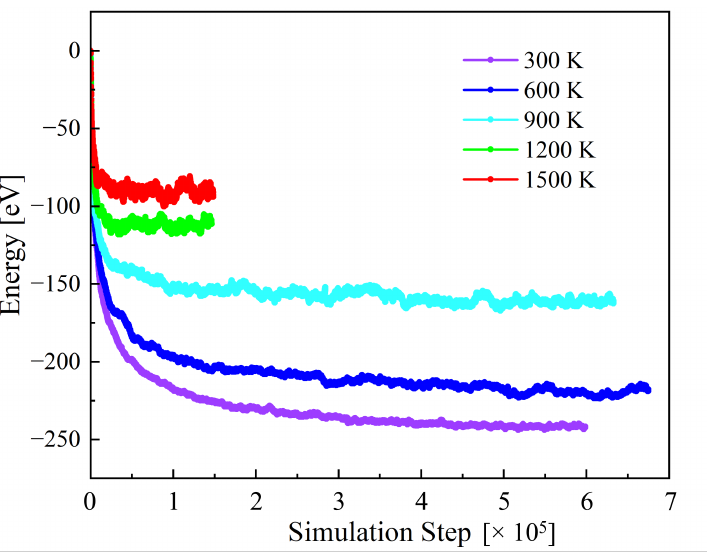
Figure 2. Energy evolution of the random Nb-Mo-Ta-W during annealing at different temperatures. The total energy of the system at the initial state is zero for easier reference.